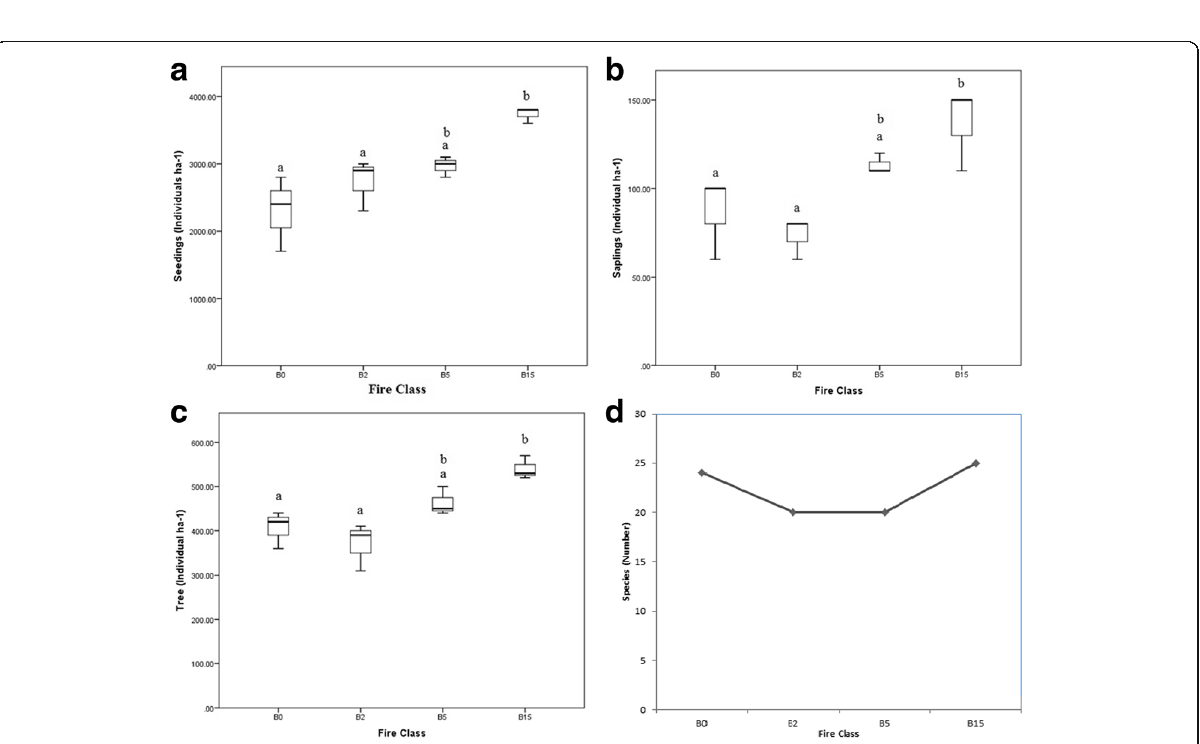
Fig. 4 Box plot of a seedlings b saplings c trees, and d the relationship between total species regenerating and fire class. Different letters denote significant differences at p < 0.05 utilizing Tukey